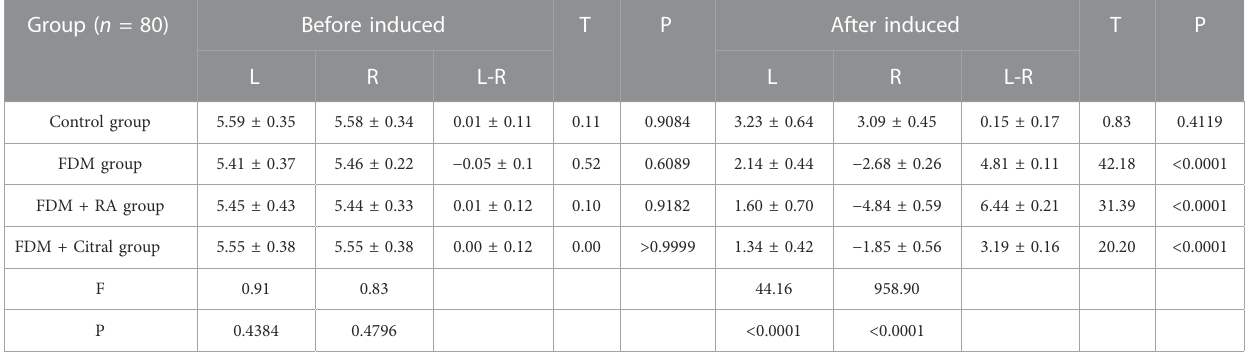
TABLE 1 RE of left and right eyes of guinea pigs before and after experimental induction (D). Group ( n =